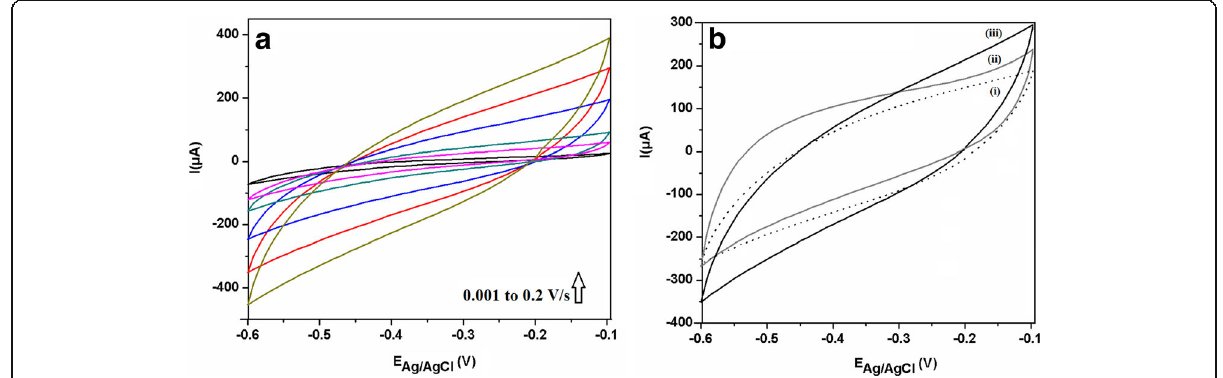
Fig. 4 CV of a HPyC3% at all scan rates. b CV of HPyCs 1 – 3% (i – iii) at 0.01